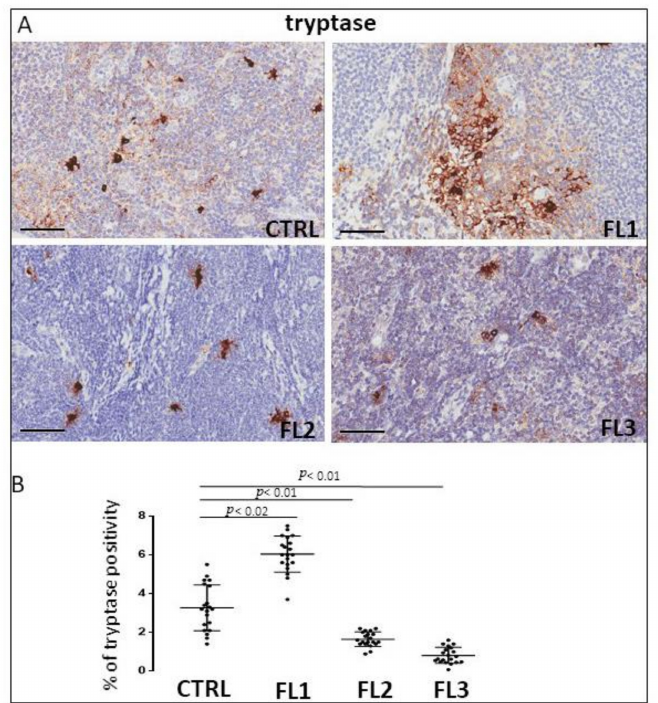
Figure 3. Immunohistochemical staining for tryptase in FL grade1 (FL1), FL grade2 (FL2), and FL grade 3 (FL3) and control samples (CTRL). Scale bar: 60 µ m ( A ). Morphometric analysis indicates the percentage of tryptase + mast cells in FL and CTRL samples ( B ).